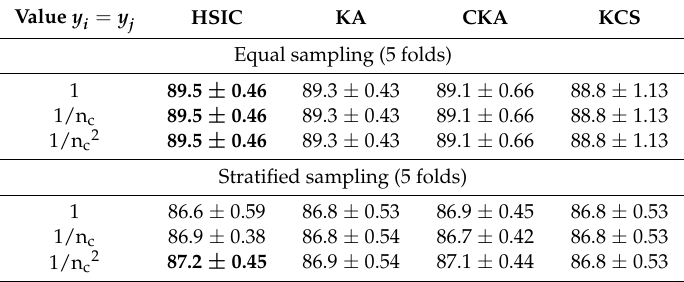
Table 3. The overall accuracy obtained for Experiment I.A.: optimizing the bandwidth parameters γ m for each input kernel K m using various kernel class separability measures and ideal kernel definitions. n c indicates the number of samples for a specified class. CKA, Centered-Kernel Alignment; KCS, Kernel Class Separability.